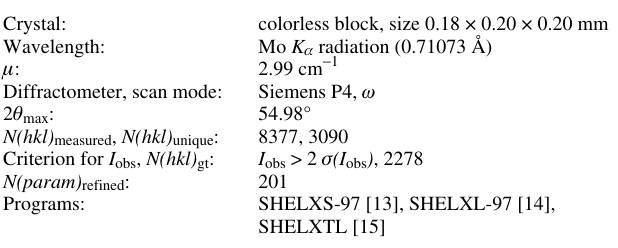
Table 1. Data collection and handling.